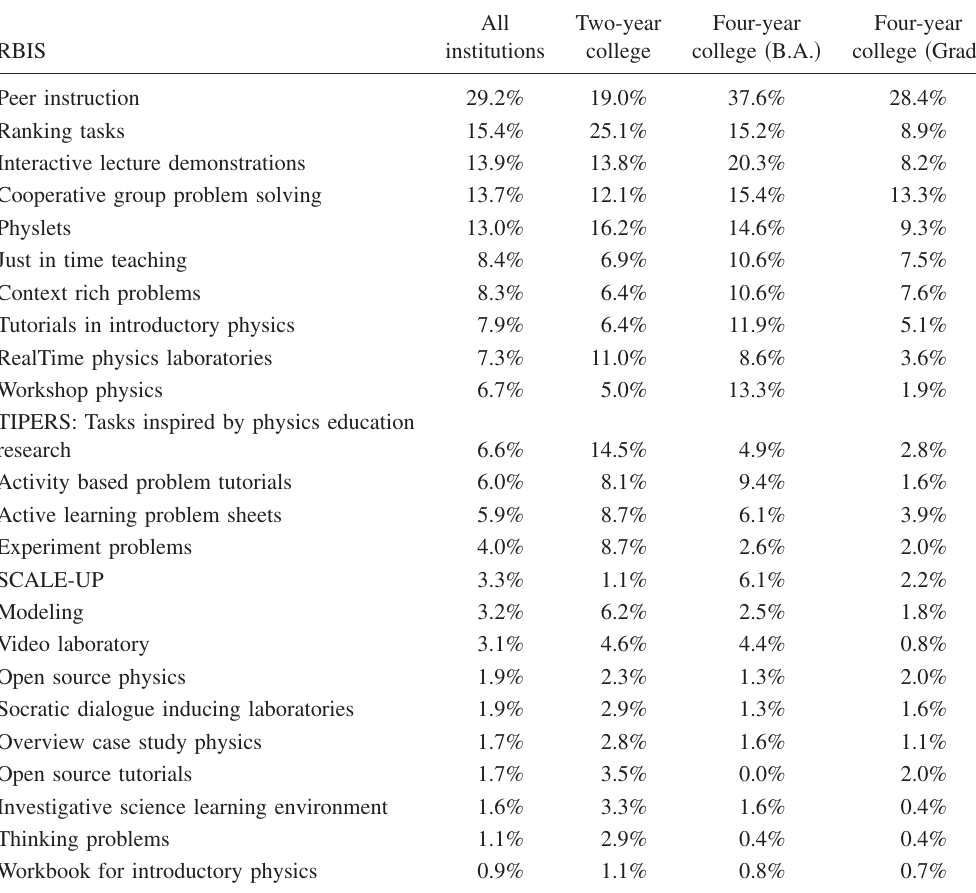
TABLE VII. Ranking of the 24 RBIS according to percentage of current users.